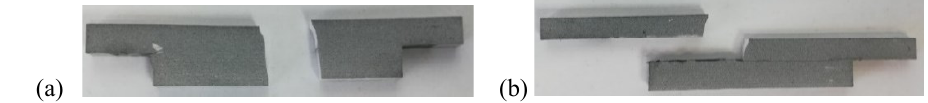
Fig. 4. Failure modes – (a) through thickness and (b) early interface failure